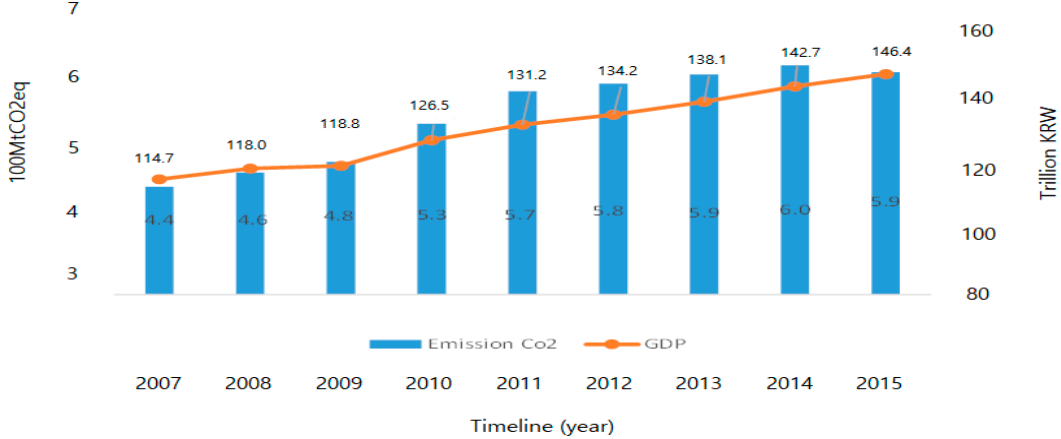
Figure 2. Gross domestic product (GDP) and emission trends in Korea. Sources: Bank of Korea;